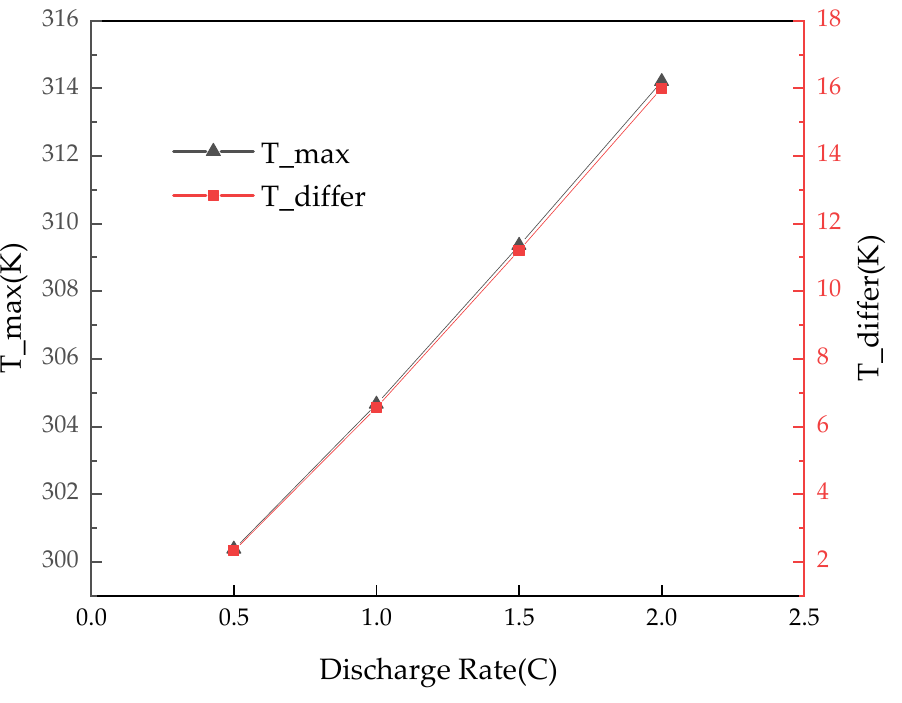
Figure 4. Battery discharge temperature at 298 K.